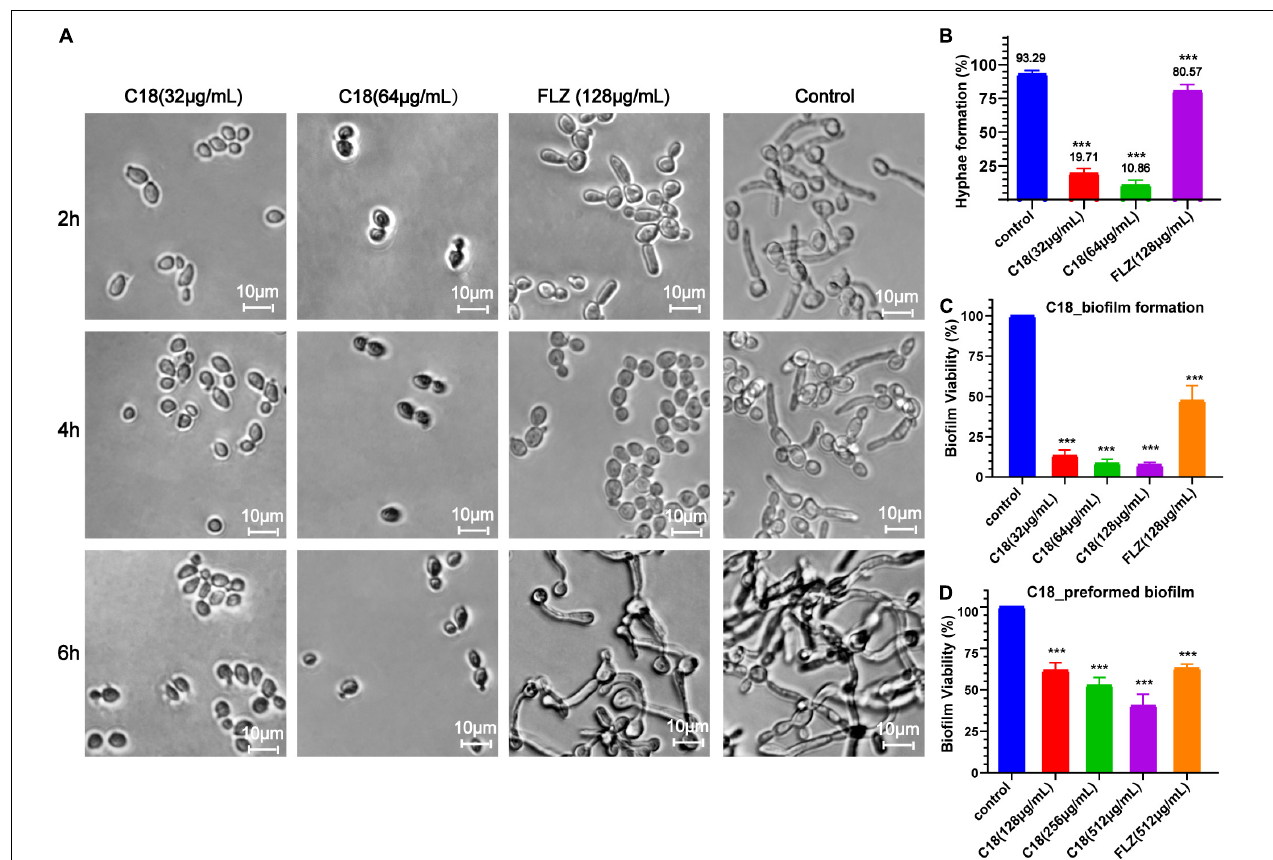
FIGURE 3 | Effect of C18 on morphogenesis and biofilm in Candida albicans . (A) The hyphal formation of C. albicans exposed to C18 was detected by invert microscope. To induce hyphae formation, RPMI-1640 with 15% FBS was added and incubated at 35 ◦ C for 2 h, 4 h, and 6 h. C18 was treated at 32 µ g/ml and 64 µ g/ml, the drug-free strain-containing medium was set as the control, and 128 µ g/ml FLZ was set as the positive control. (B) The morphogenesis inhibitory effect of C18 was evaluated and recorded as a percentage. Candida albicans cells was incubated with C18 (32 µ g/ml and 64 µ g/ml) or FLZ (128 µ g/ml) in RPMI-1640 medium containing 15% FBS at 35 ◦ C for 6 h, and at least 300 cells was counted using a microscope. C. albicans cells without any treatment were set as control. (C,D) Effect of C18 on biofilm formation (C) and preformed biofilm (D) in C. albicans by the 2,3-bis(2-methoxy-4-nitro-5-sulfophenyl) 2H-tetrazolium-5-carboxanilide sodium salt (XTT) reduction assay. For biofilm formation, C. albicans cells was incubated with C18 (32 µ g/ml, 64 µ g/ml, and 128 µ g/ml) or FLZ (128 µ g/ml) in RPMI-1640 medium at 37 ◦ C for 24 h. For preformed biofilm, C. albicans cells was incubated in RPMI-1640 medium at 37 ◦ C for 24 h to form mature biofilm. Next, supernatant was discarded and C18 (128 µ g/ml, 256 µ g/ml, and 512 µ g/ml) or FLZ (512 µ g/ml) was added and co-incubated for another 24 h. XTT reduction was performed to determine the level of biofilm viability at various treatment and colorimetric absorbance was measured at 490 nm. Error bars represent standard deviation of three independent experiments. ***p < 0.001 compared to the control